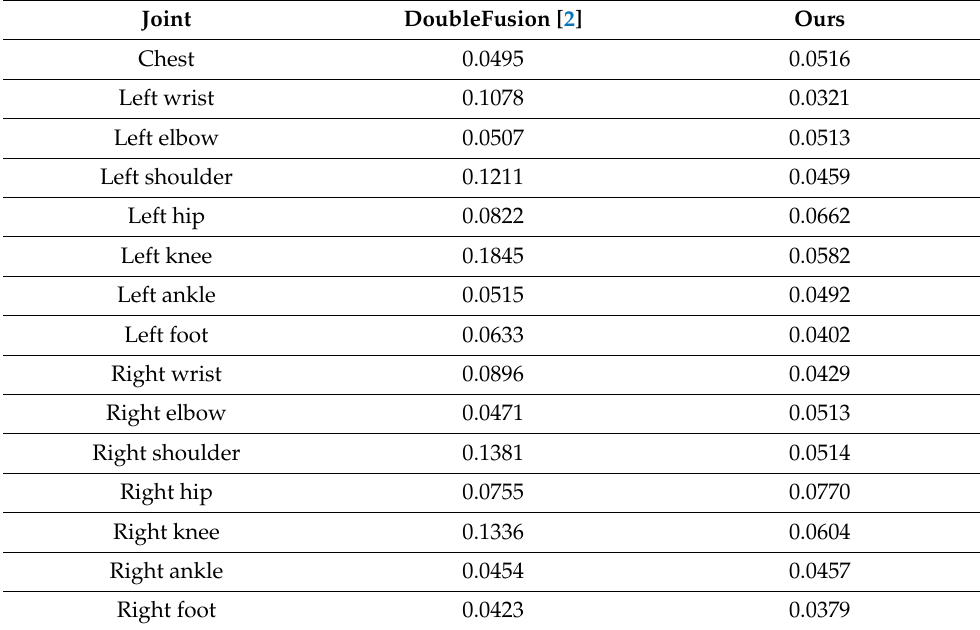
Table 1. Maximum instant errors on the entire sequence of each joint.